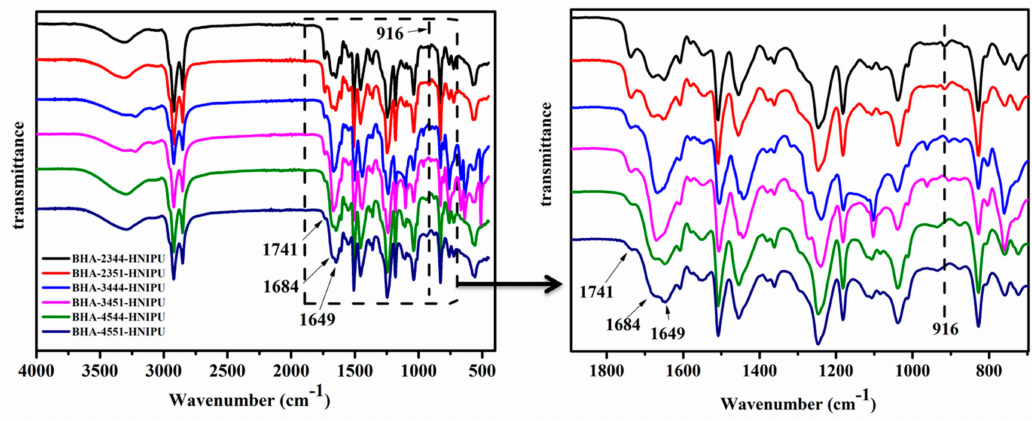
Figure 8. FTIR spectra of